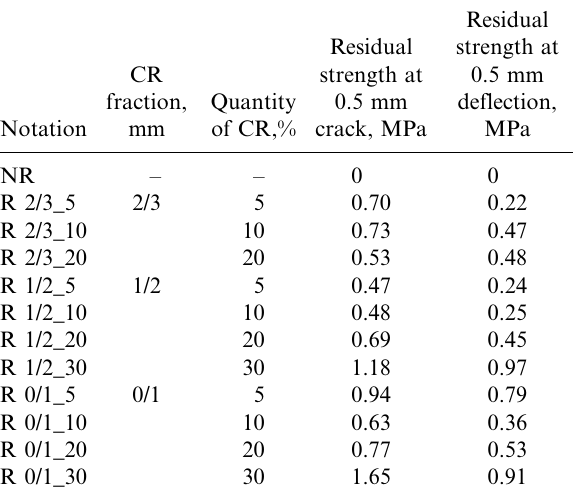
Table 2. Evaluation of concrete fracture plasticity